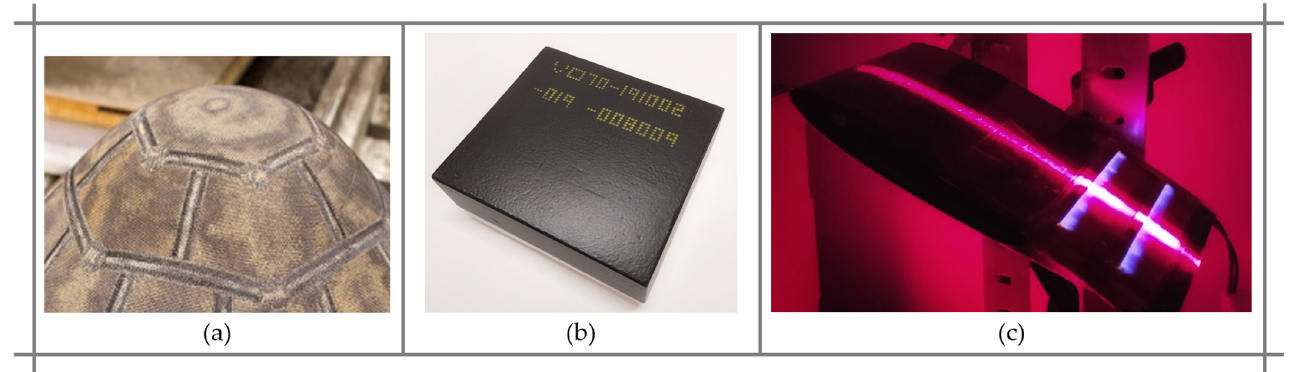
Figure 7. Examples of engineering applications of ( a ) TPS woven material (adapted from Uyanna et al. (2020) based on ref. [11] with the permission of Elsevier), ( b ) TBC space shuttle tile, and ( c ) DBD plasma actuators during discharge phenomenon.